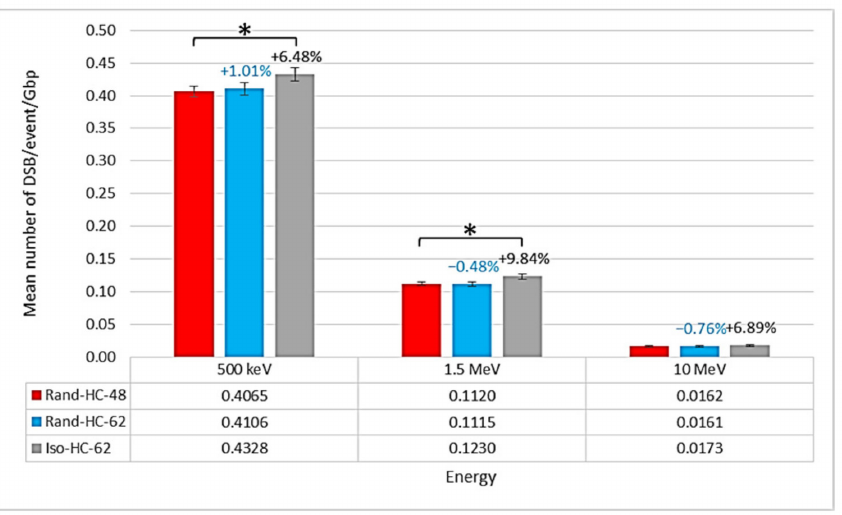
Figure 1. Comparison of the mean number of DSBs/event/Gbp for the three endothelial geometries (Rand-HC-48, Rand-HC-62, and Iso-HC-62). The figures above the bars indicate the relative increase in mean DSBs/event/Gbp number for the Rand-HC-62 and Iso-HC-62 nuclei compared to the Rand- HC-48 nucleus. Asterisks above the bars represent the degree of confidence on the difference between the two related mean values assessed by Student’s t -test (* p < 0.05).